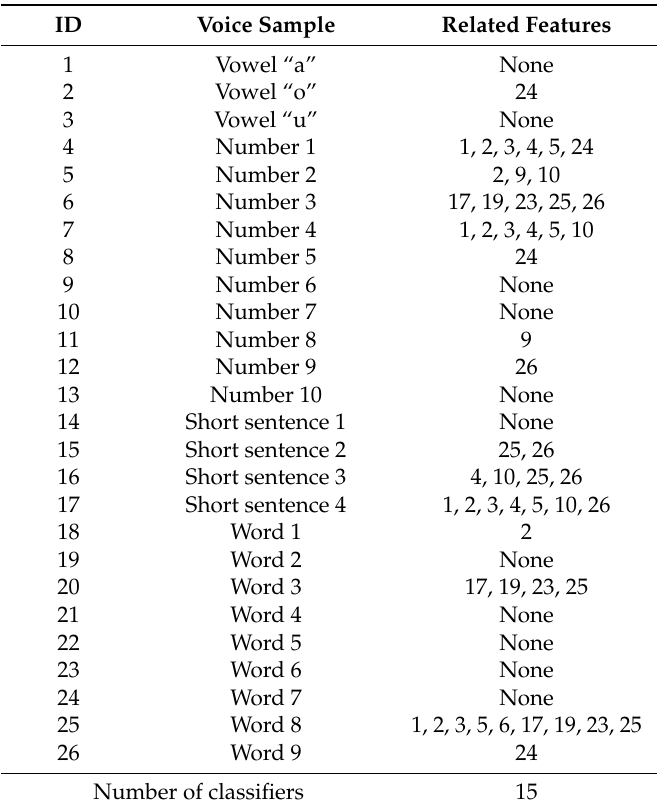
Table 5. Selected features using a medium correlation factor.